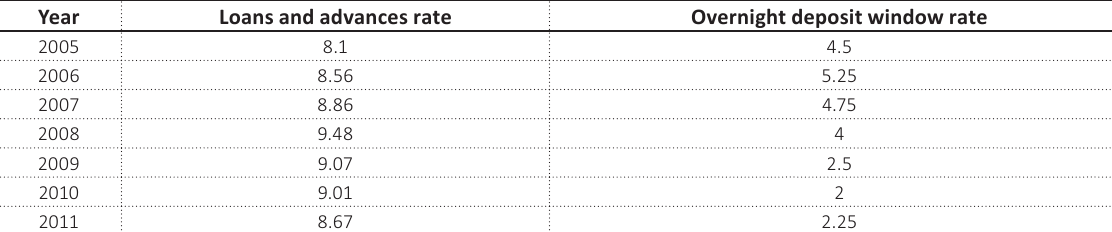
Table 1. Independent variables (in %) for six years (2005–2011)